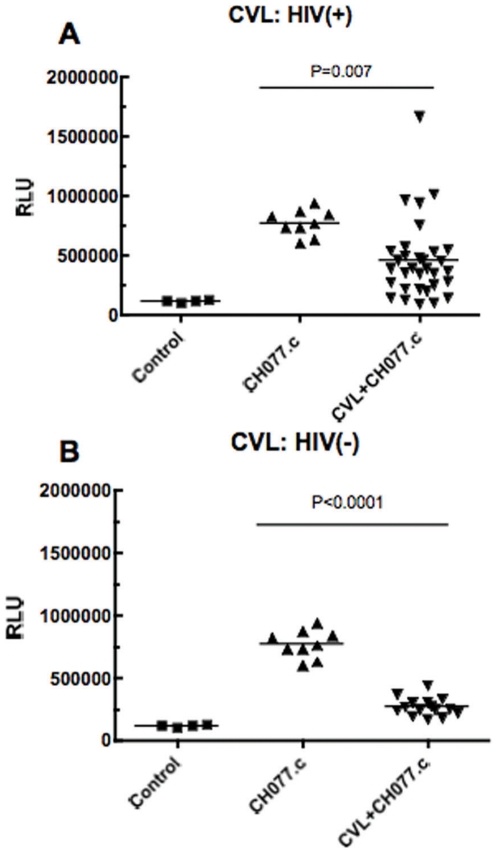
Analysis of CH077.c (R5; transmitted/founder Virus) activity in CVL from HIV(+) and HIV(−) women.Thirty two HIV(+) CVL and 15 HIV(−) CVL were diluted 1∶4 and incubated with the R5 transmitted/founder HIV-1 virus CH077.c at MOI 1 for 1h at 37°C prior to infecting TZM-bl cells. Control wells incubated with CVL alone were set up as negative controls and CH077.c wells were set up as positive controls. Each data point in Figure 4A represents one of 32 individual patients. In Figure 4B each data point represents one of 15 individuals. Significant differences between control (CH077.c) and CH077.c + CVL are indicated in Figure.